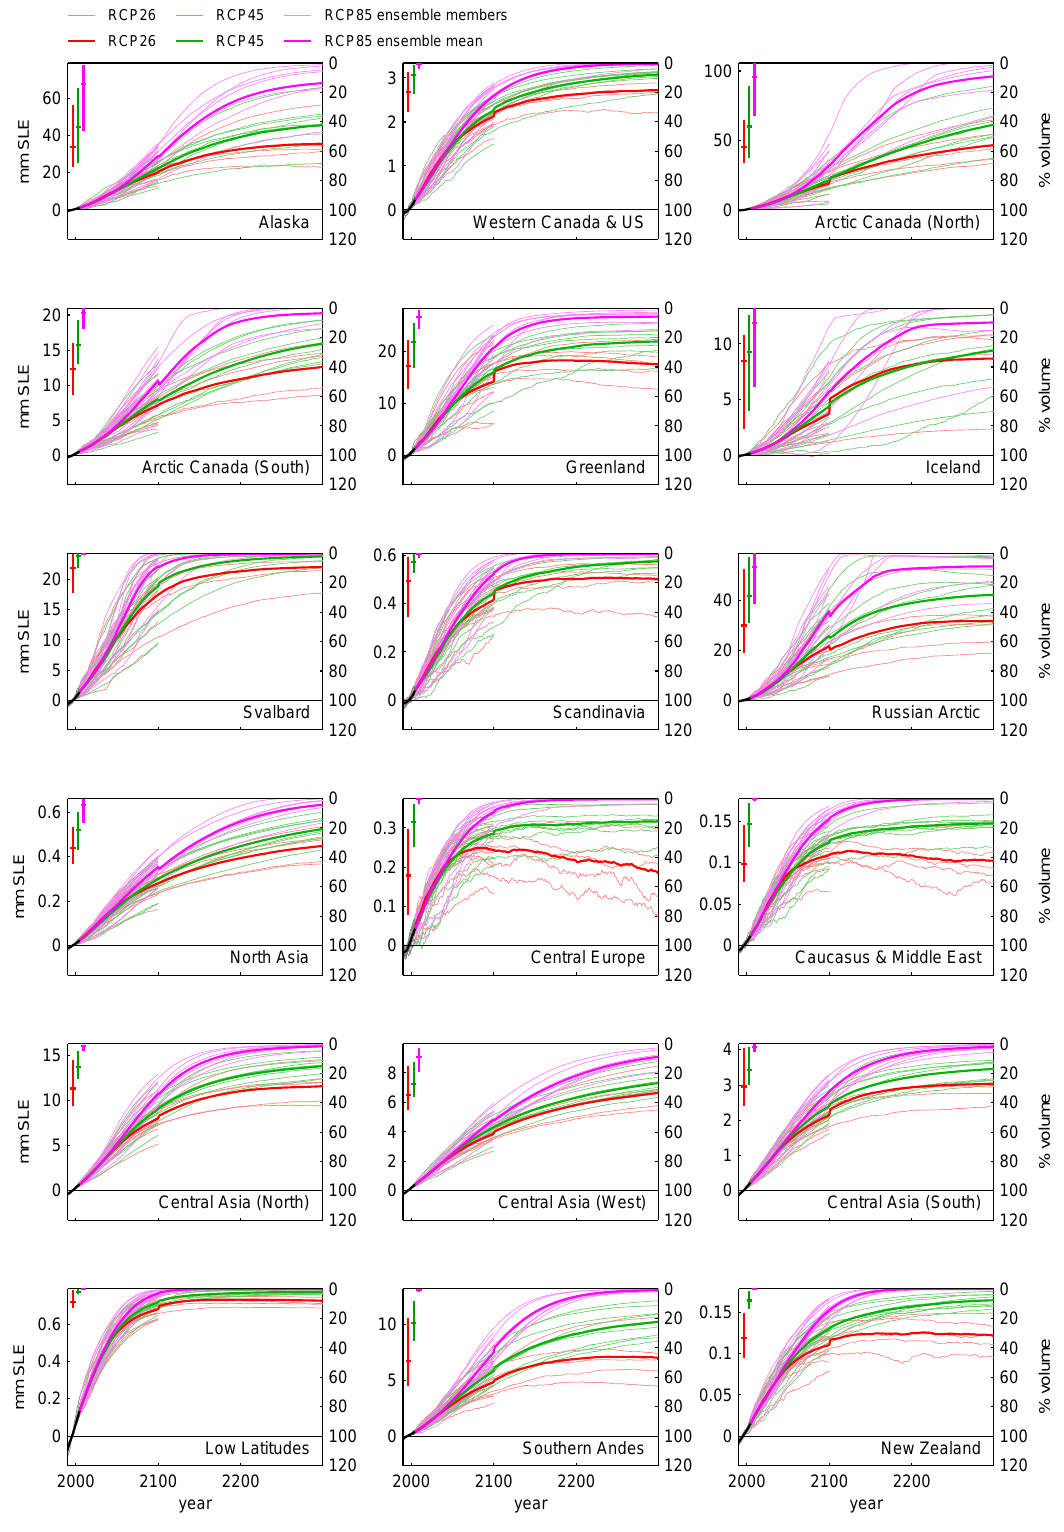
Fig. 23. Cumulative regional surface mass balances relative to the 1986–2005 mean from the model forced with CMIP5 projections, up to the year 2300. Light colored lines: model forced by individual CMIP5 ensemble members, solid lines: means of light colored lines. Crosses on the left indicate mean and range of ensemble for each RCP scenario in the year